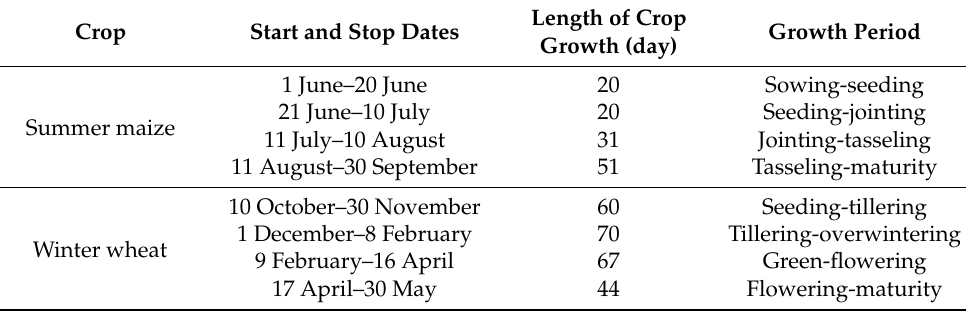
Table 1. Characteristics of four growth stages for winter wheat and summer maize. Crop Start and Stop